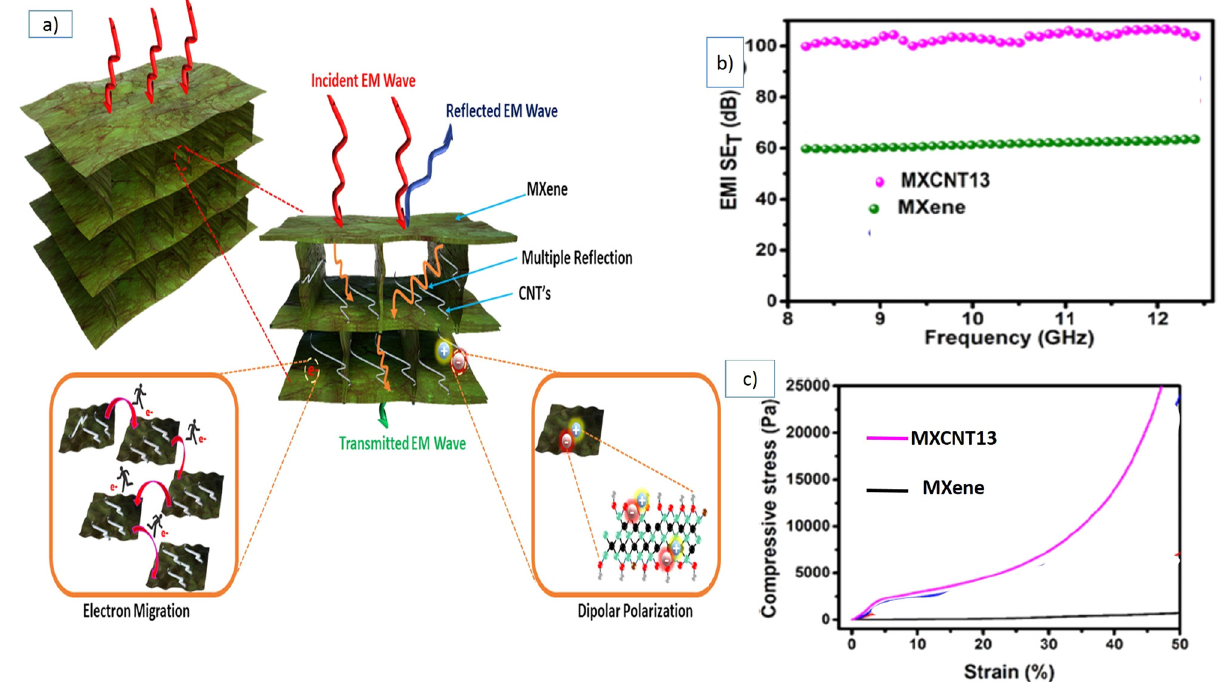
Figure 6: ( a ) Schematic representation of the possible mechanism of EMI shielding in MXCNT aerogel foam; ( b ) EMI SE T of MXene and MXCNT13 aerogels with 3 mm thickness as a function of frequency; and ( c ) stress – strain curves of MXene and MXCNT13 aerogels [ 106 ] .